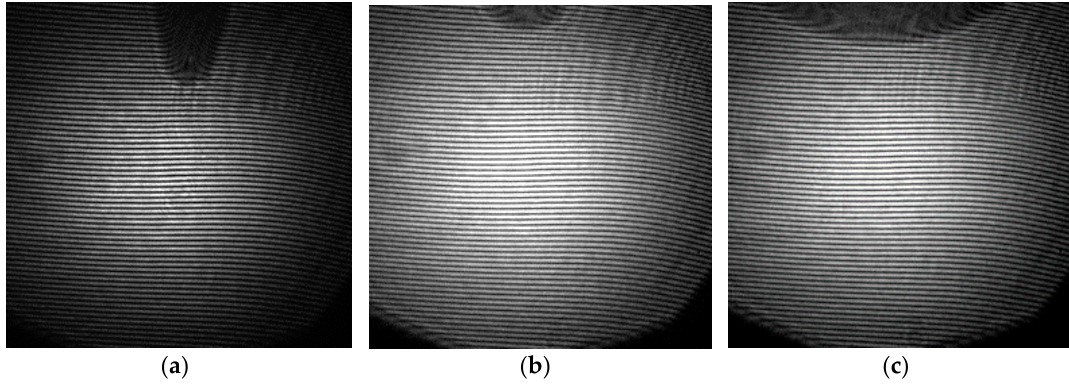
Figure 5. Interference images without distributions (background images): ( a ) cone terminal, radius of curvature = 2.5 mm; ( b ) cone terminal, radius of curvature = 5 mm; ( c ) spherical terminal, diameter = 40 mm.